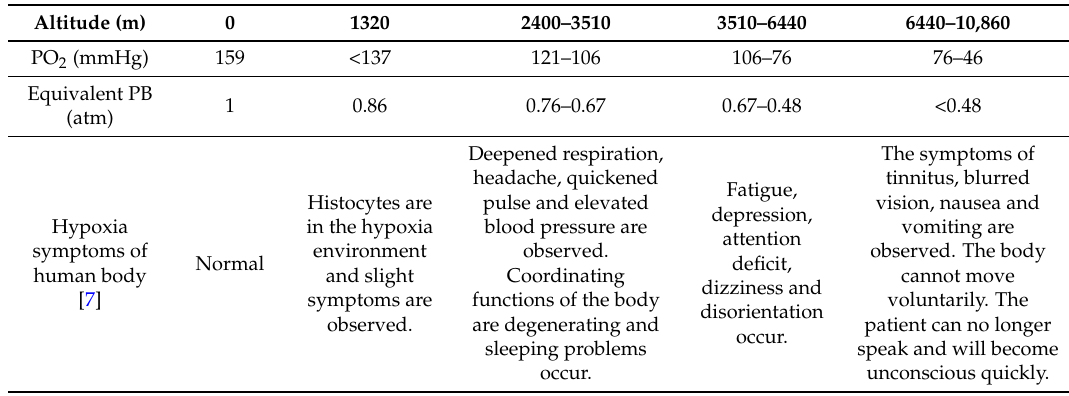
Table 2. Hypoxia responses of human body at different